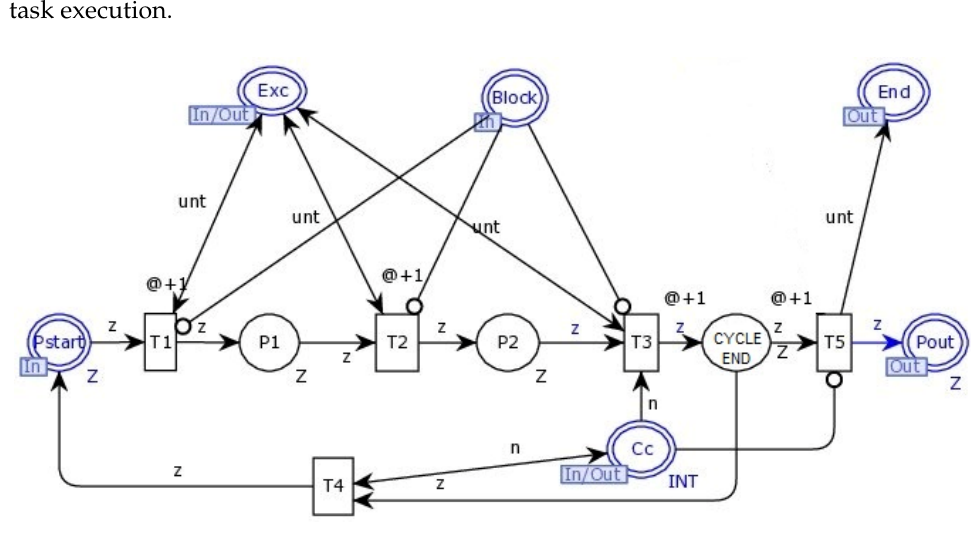
Figure 6. The three-phase TASK sub-module.